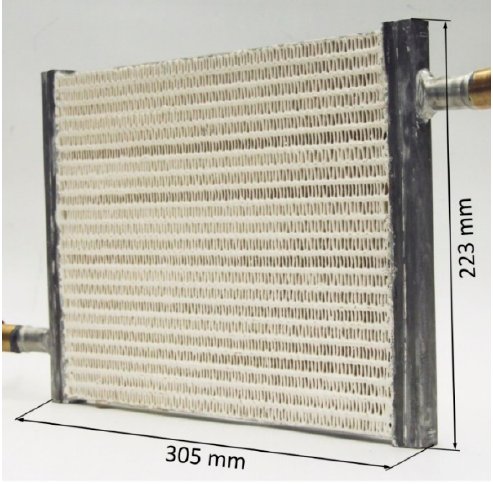
Figure 5. Coated flat tube–fin heat exchanger [33].